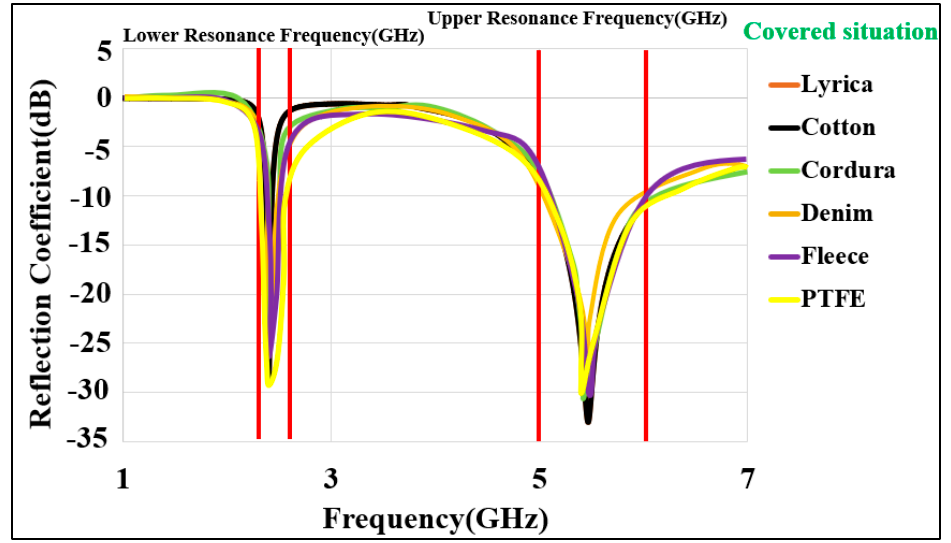
Figure 14. Reflection coefficient for the antenna covered by various types of fabric . ( Textile fabrics relative permittivity ( ε r ): Cordura/Lycra: 1.50, denim: 1.47, fleece: 1.02, cotton: 1.60, and PTFE: 2.1.